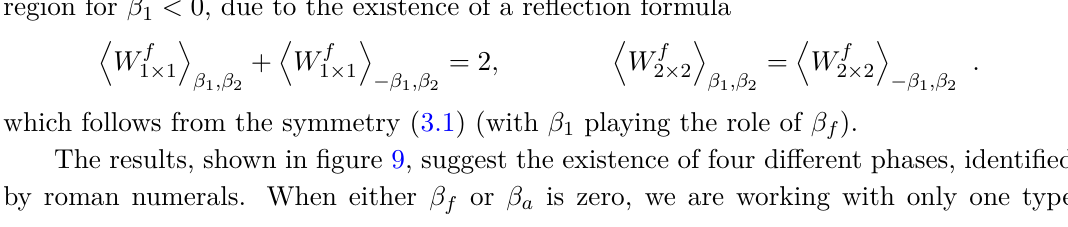
Figure 7 . First derivative of the entropy with respect to W f lattice sizes and β a . The value of β a has a large impact on the dependence on the lattice size. The colored region around the markers is an estimate of the error based on independent